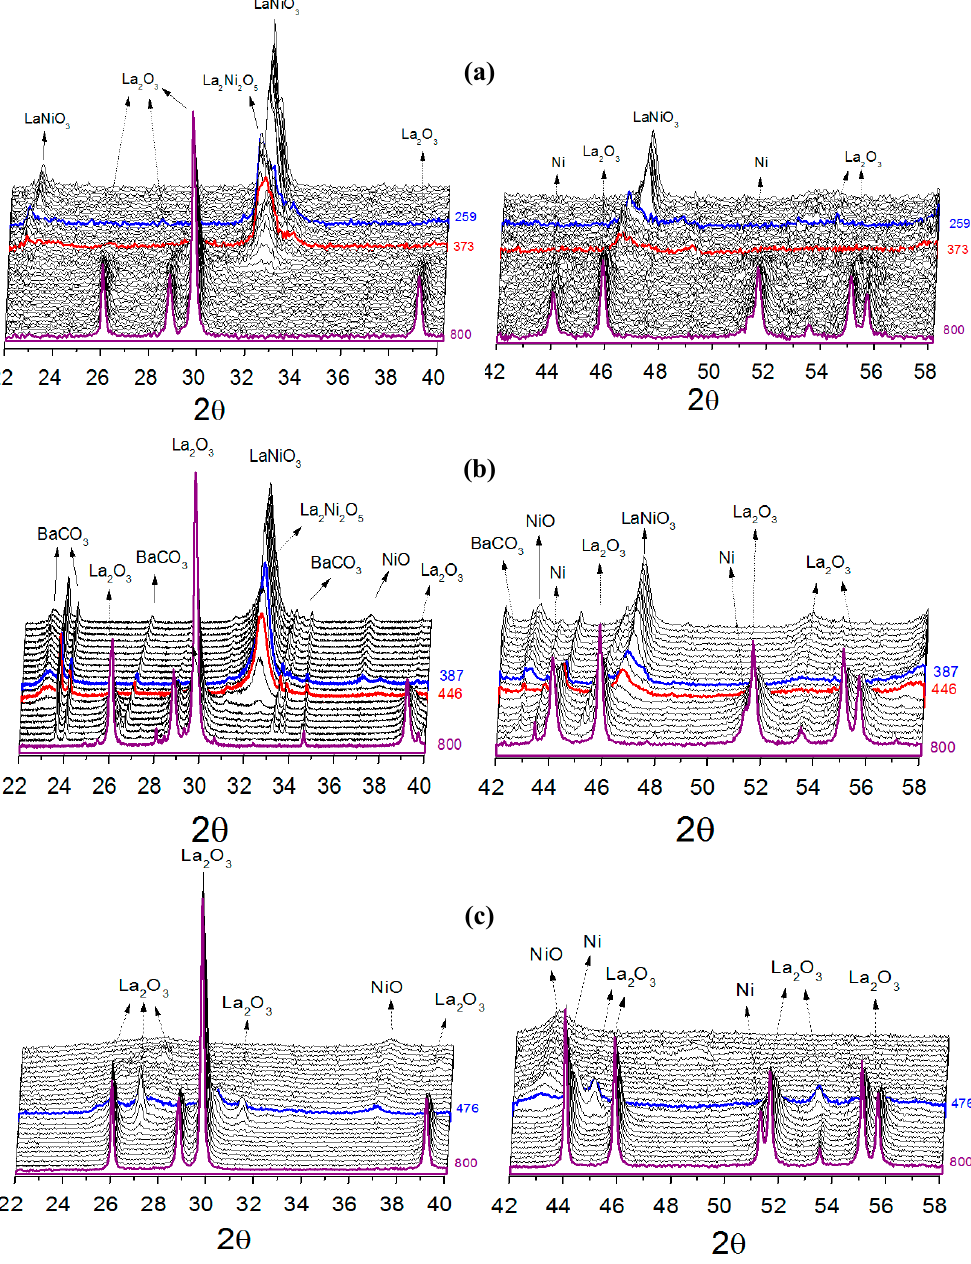
Figure 2. X-ray diffractograms of the precursors under reducing atmosphere. ( a ) LaNiO 3 (upper panels); ( b ) La 0.8 Ba 0.2 NiO 3 (central panels); and ( c ) NiO/La 2 O 3 (bottom panels).